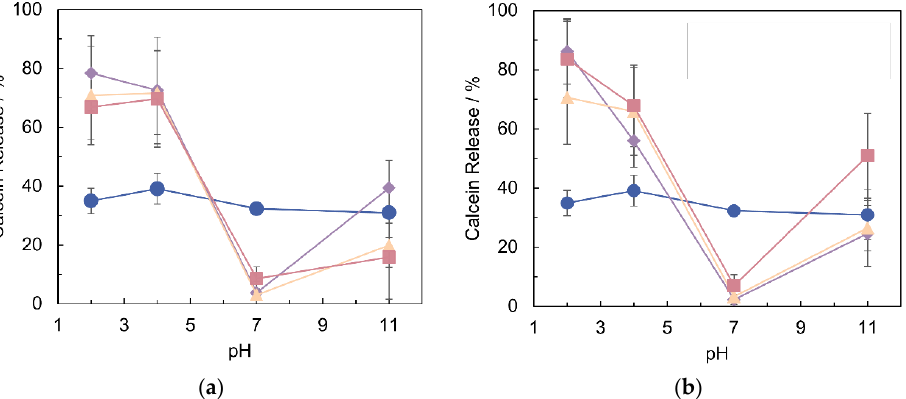
Figure 4. Calcein release profiles after 2 h of incubation at 37 °C and different pHs. Blue circles: LIP; purple diamonds: 2.5% of copolymer; orange triangles: 5% of copolymer; pink squares: 10% of copolymer. ( a ) PLU-PD PLCs. ( b ) PLU-PAA PLCs. Results are expressed as mean ± standard deviation (SD), n = 3.